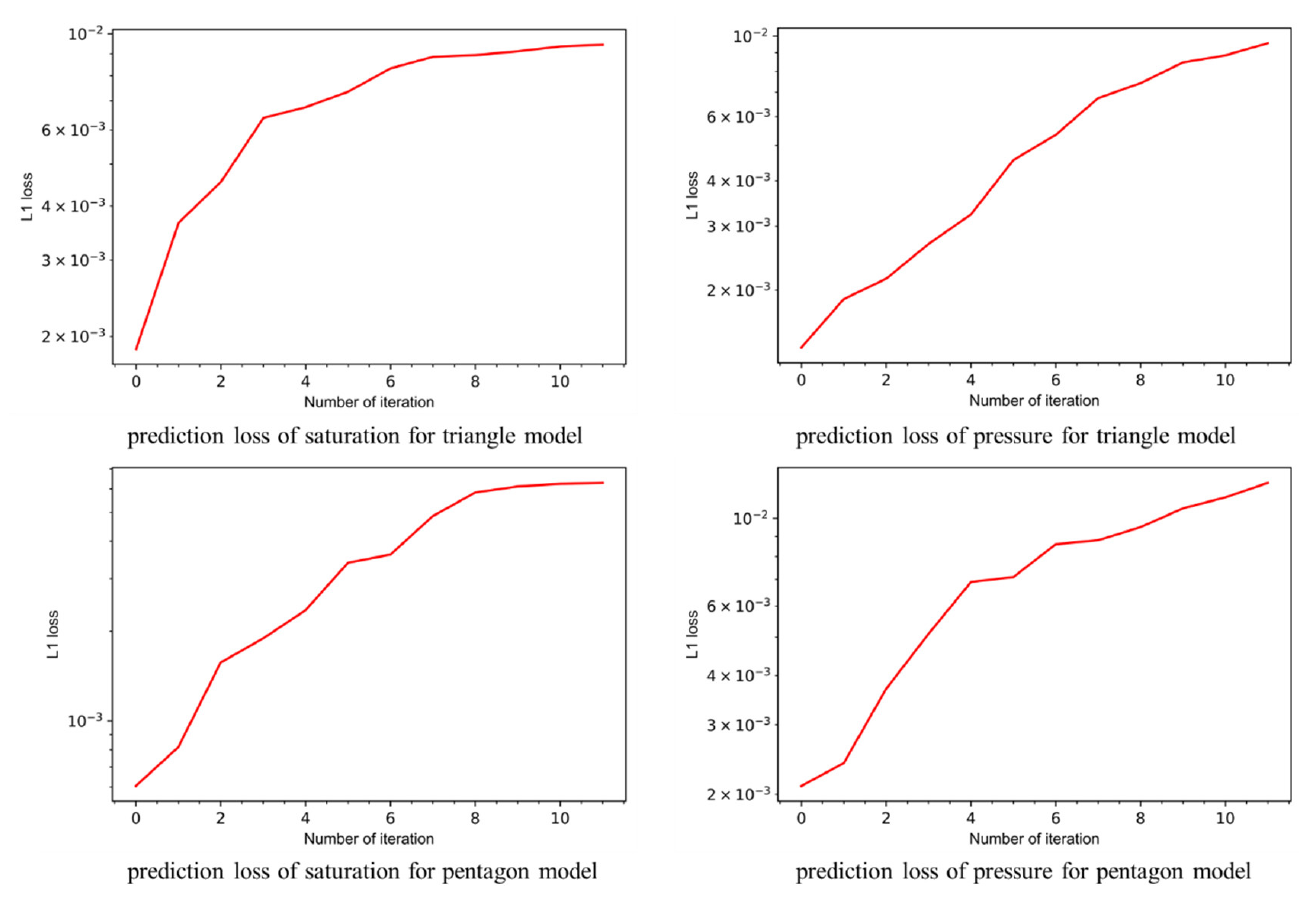
Table 4. The time-consuming nature of both the network and simulator.